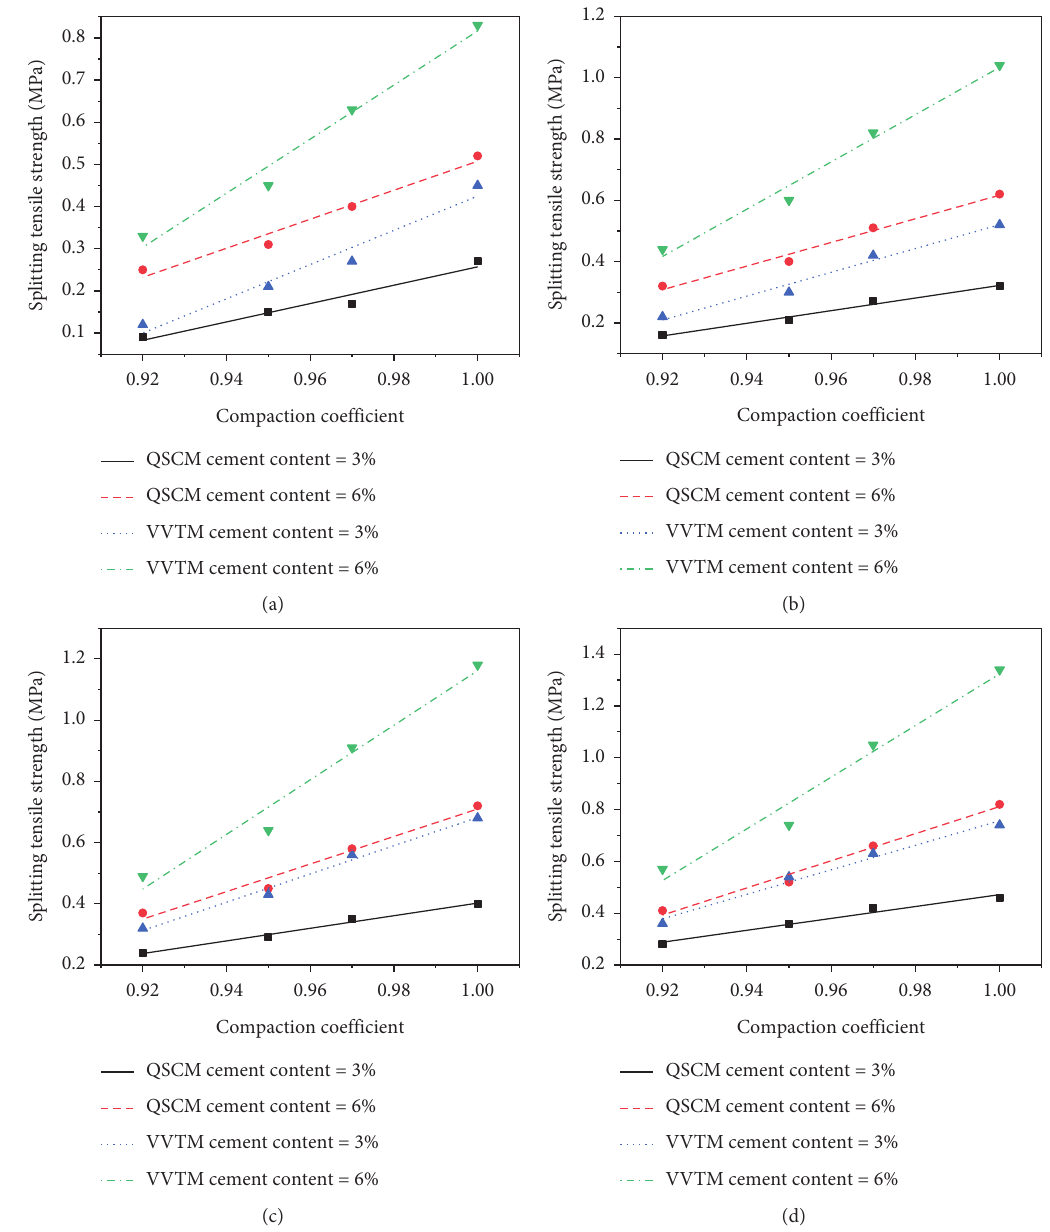
Figure 8: Influence of compaction coefficient on SPS of CSL compacted using VVCM and QSCM. (a) 7d. (b) 14d. (c) 28d. (d) 90